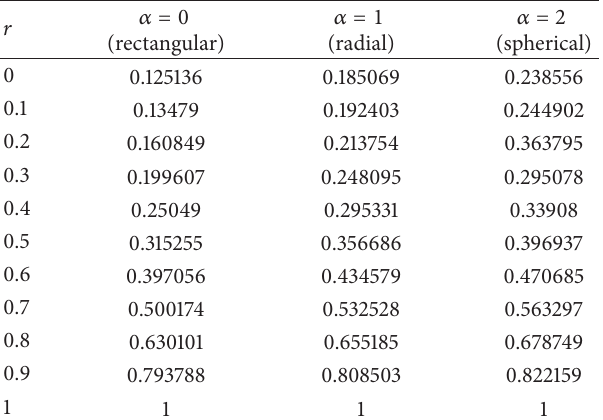
Table 1: Comparison of the temperature values in fins with rectangular, radial, and spherical profiles. Here 𝑀 = 4 and 𝑛 = 1